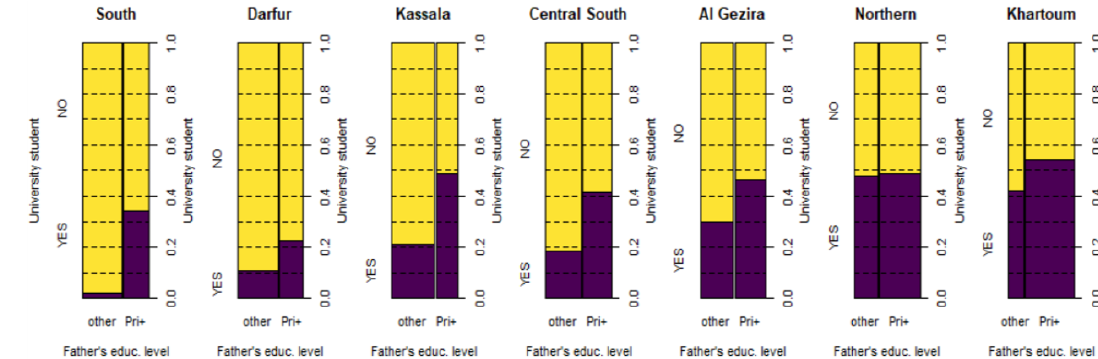
Figure 7. University attendance rates by father’s education level for 19–21-year-olds, by region.